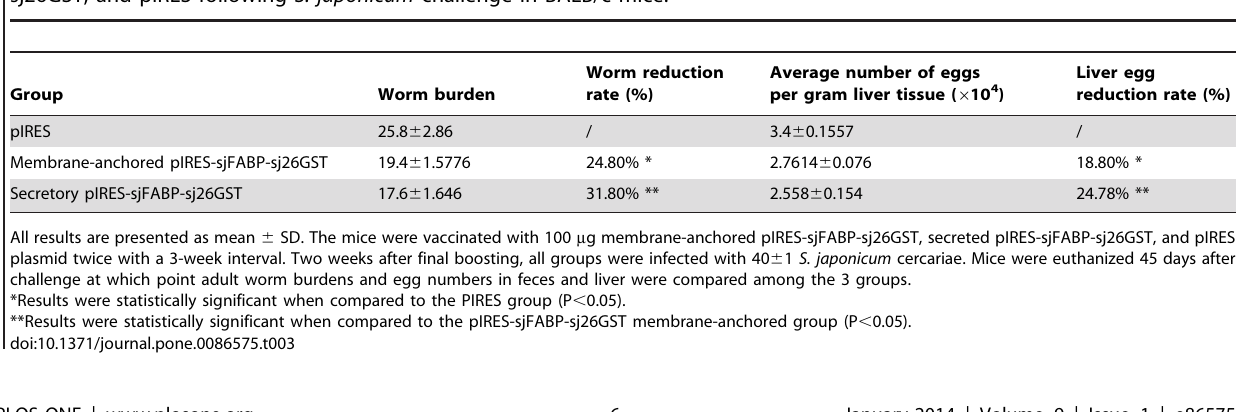
Table 3. Protective effects of immunization with plasmid membrane-anchored pIRES-sjFABP-sj26GST, secreted